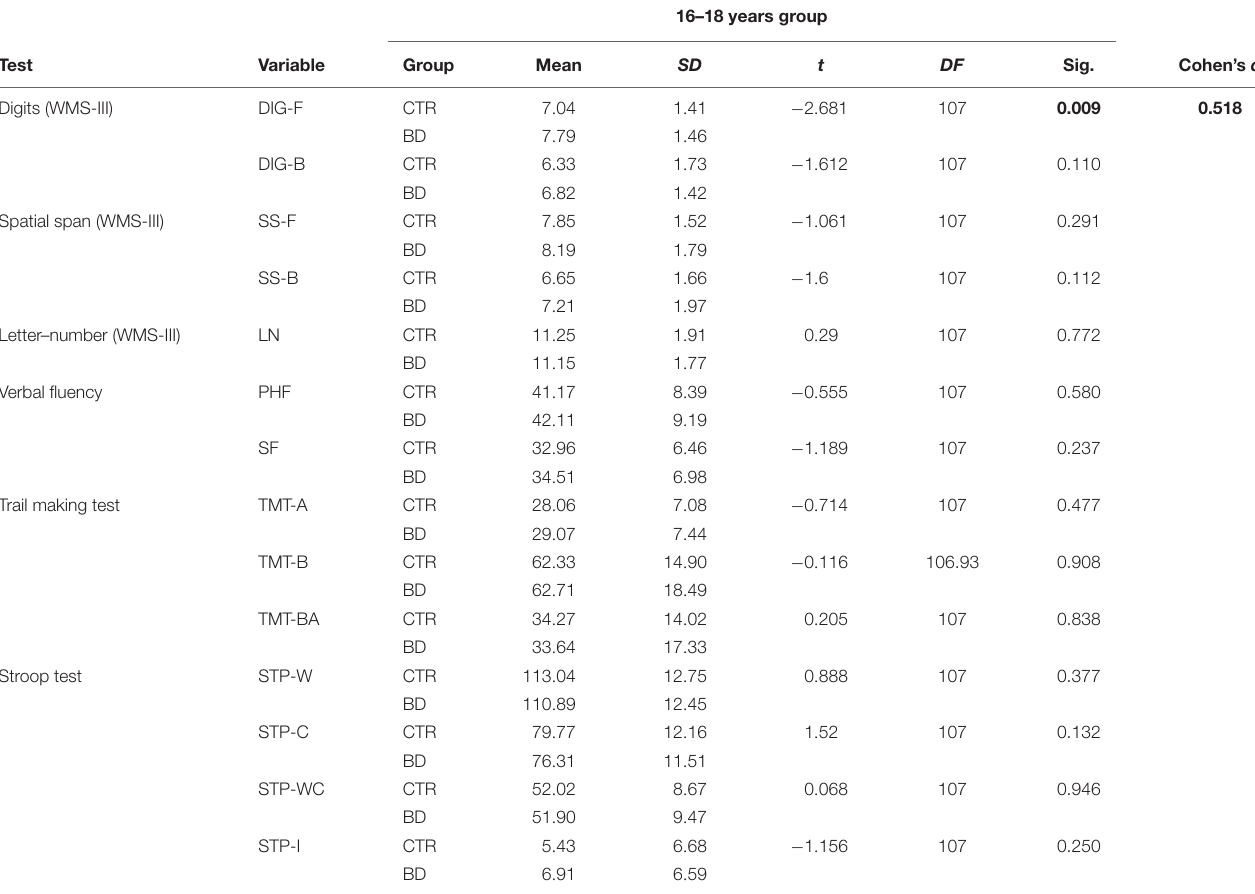
TABLE 4 | Mean differences between BD and control groups of 16–18-year-old subjects.